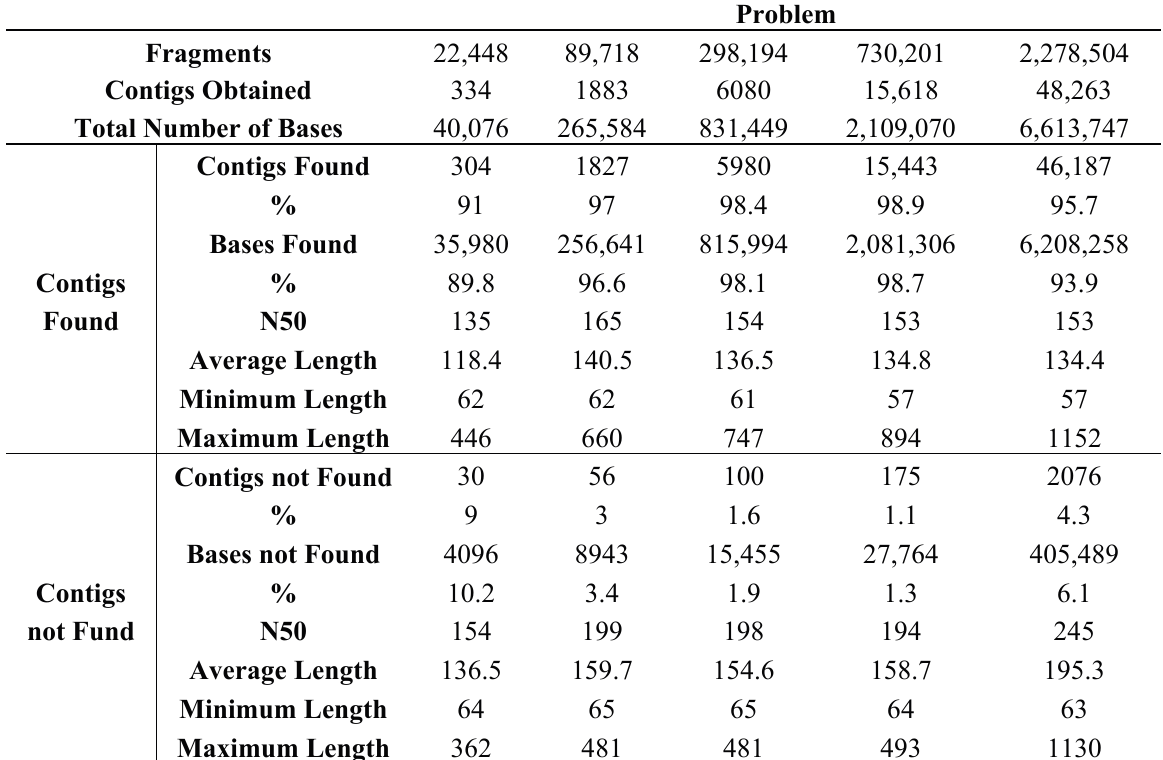
Table 10. Algorithm 1, F 1 objective function, Minimum Spanning Tree